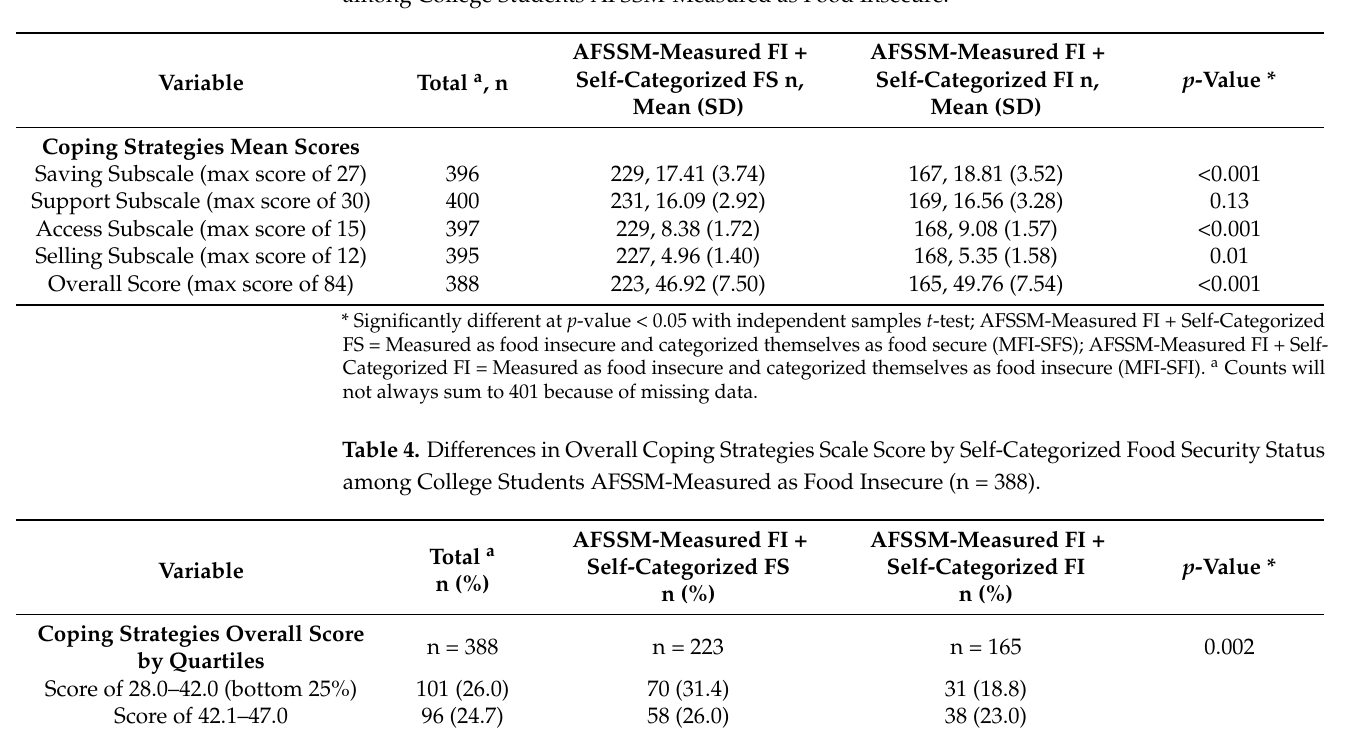
Table 3. Differences in Coping Strategies Subscale Scores by Self-Categorized Food Security Status among College Students AFSSM-Measured as Food Insecure.